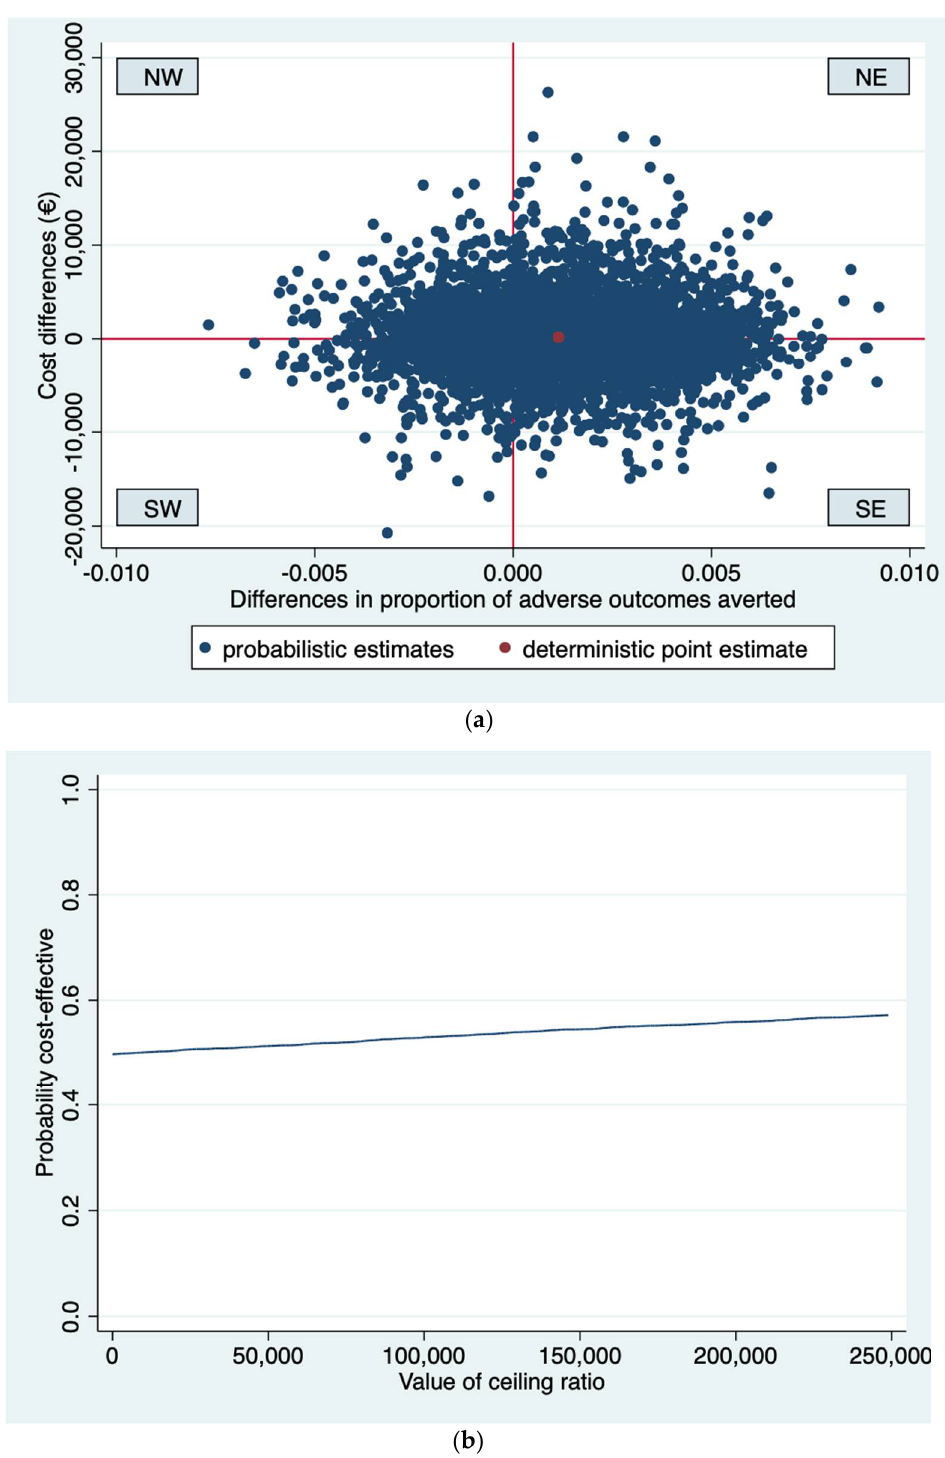
Figure 3. ( a ) Cost-effectiveness plane for analysis 2 (time horizon six months after birth, adverse